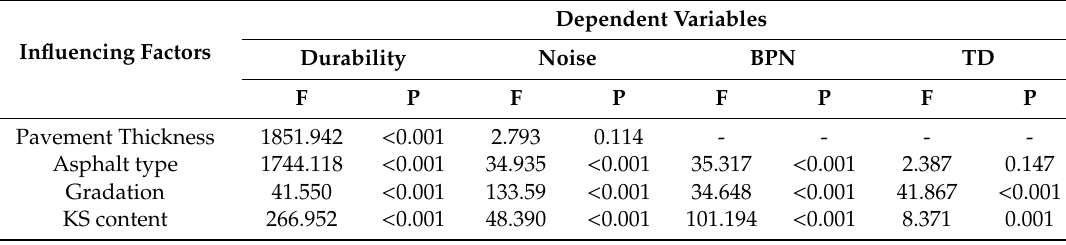
Table 11. Results of ANOVA of di ff erent factors on durability, noise and skid